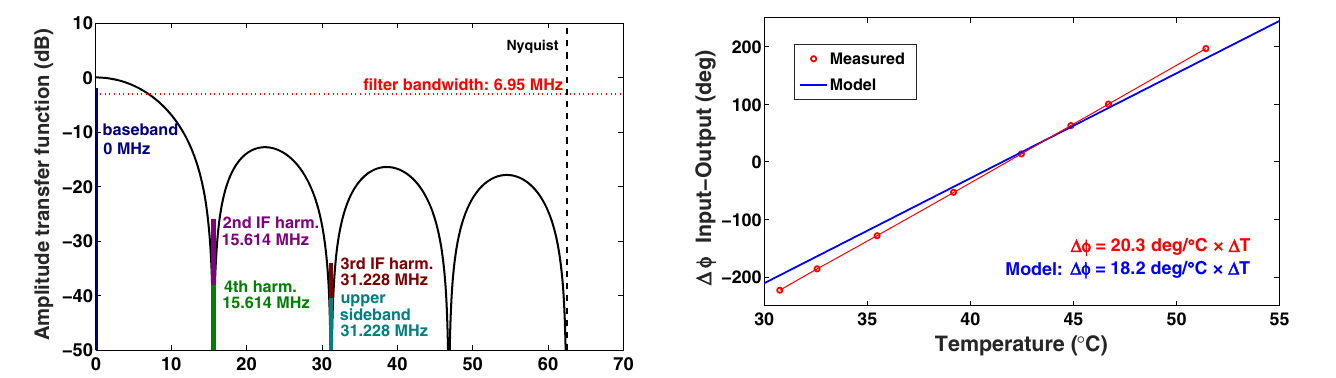
FIG. 25. Phase slippage between output and input of the S-band traveling wave structures due to temperature variations of the structure. The ideal operating temperature, where output and input phases are equal, is found to be 41 . 7 °C in this